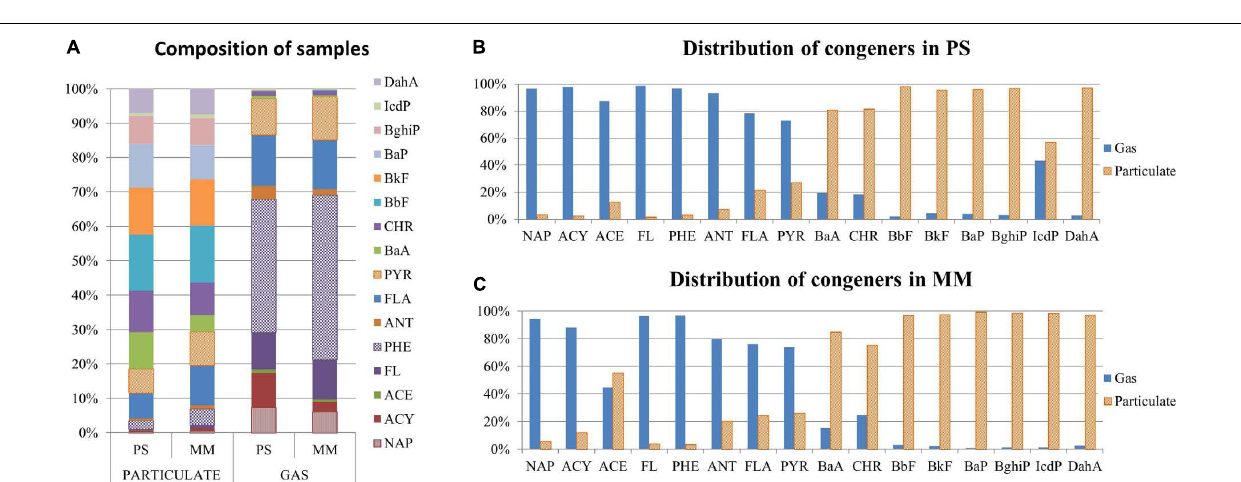
Frontiers in Environmental Science |